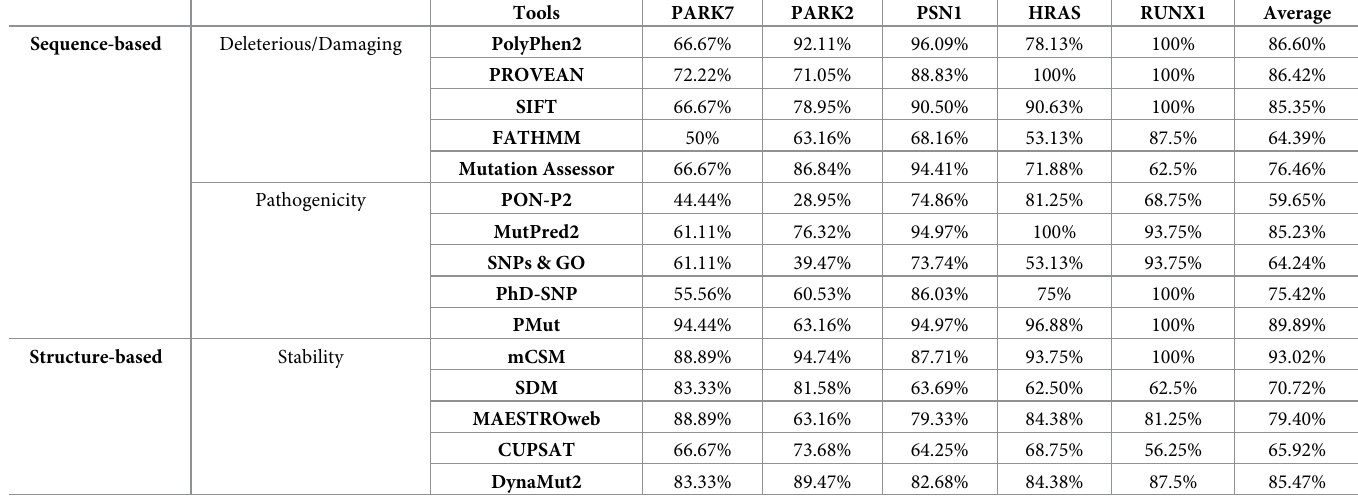
Table 3. Percentage of deleterious/ pathogenic/ destabilizing single point mutations predicted by all the fifteen tools for PARK7, PARK2, PESN1, HRAS and